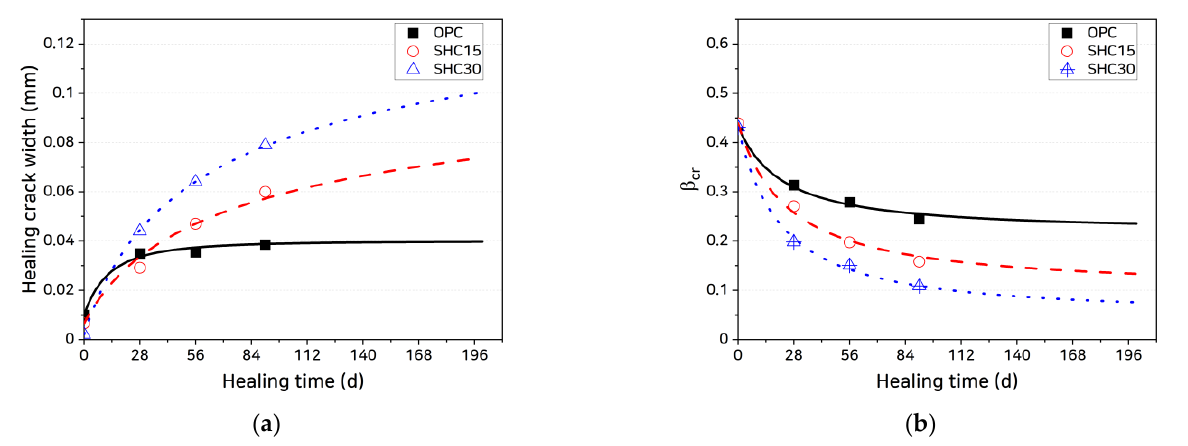
Figure 11. Growth of healed crack width and decrease in β cr with increasing healing age: ( a ) healed crack widths and ( b ) β cr . Table 3. Parameters for healed crack width and crack formation factors.